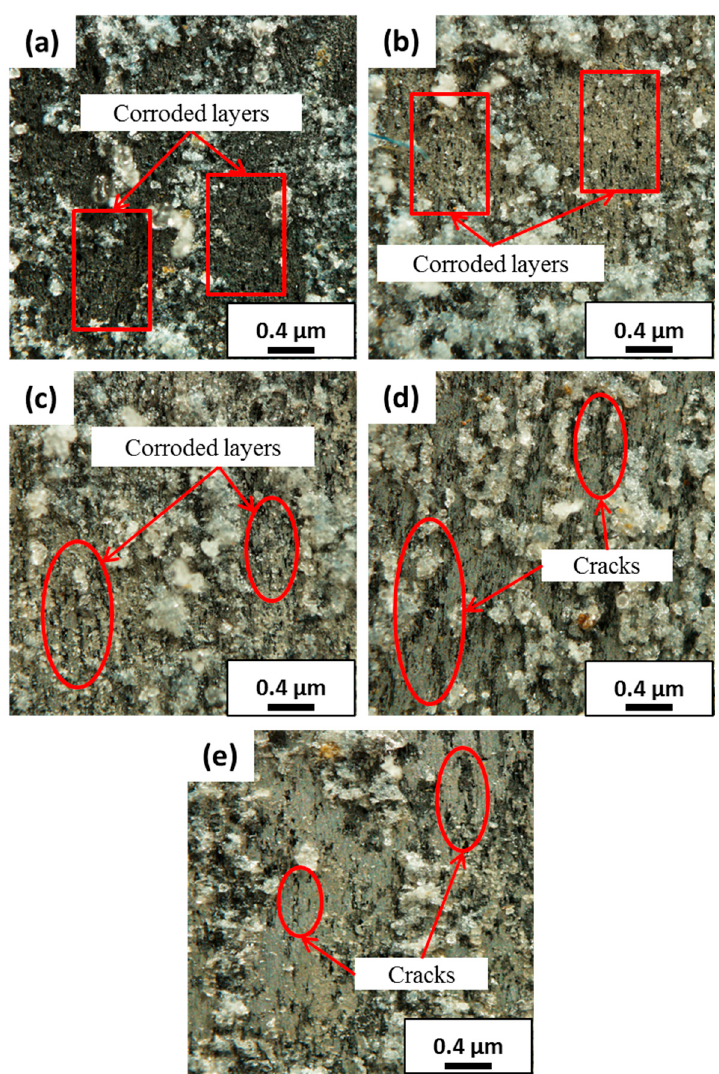
Figure 9. Exfoliation corrosion (EXCO) morphologies of the creep aged 7050 aluminum alloy with various initial tempers: ( a ) retrogression; ( b ) retrogression and re ‐ aging (RRA); ( c ) RCA ‐ 90 MPa; ( d ) RCA ‐ 180 MPa; ( e ) RCA ‐ 270 MPa.